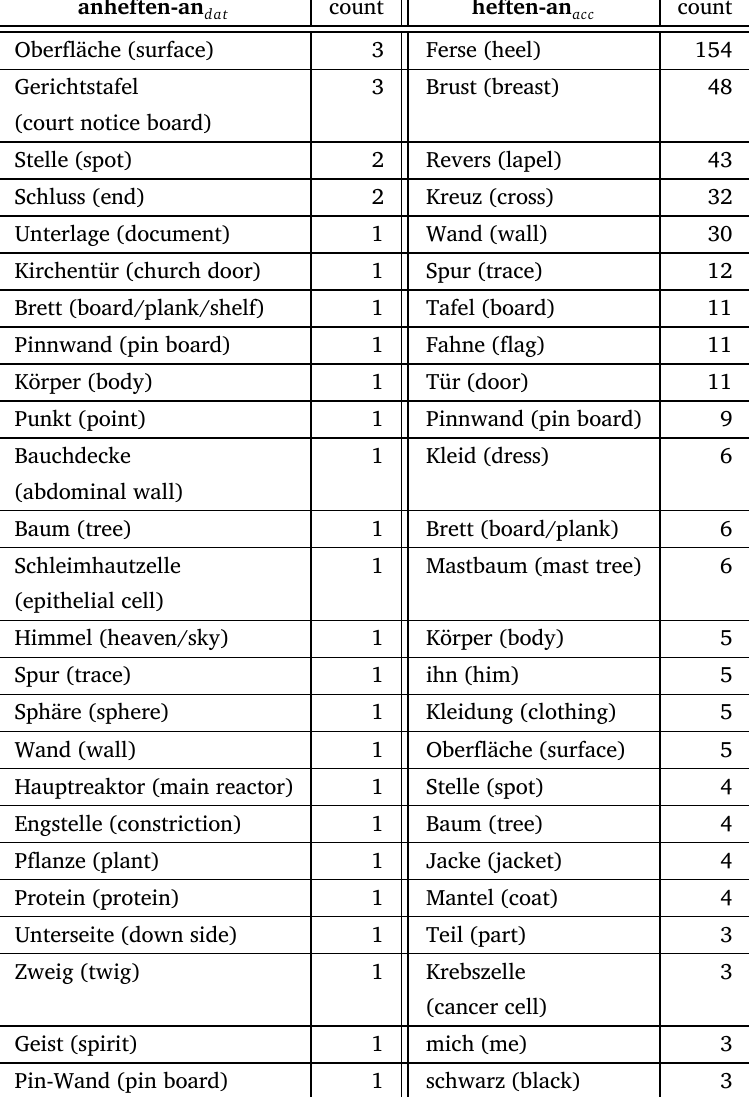
Table 4: Most frequent dimensions for two sample vectors representing subcate- gorization slots of the verbs heften ( to attach ) and an j heften ( to attach to